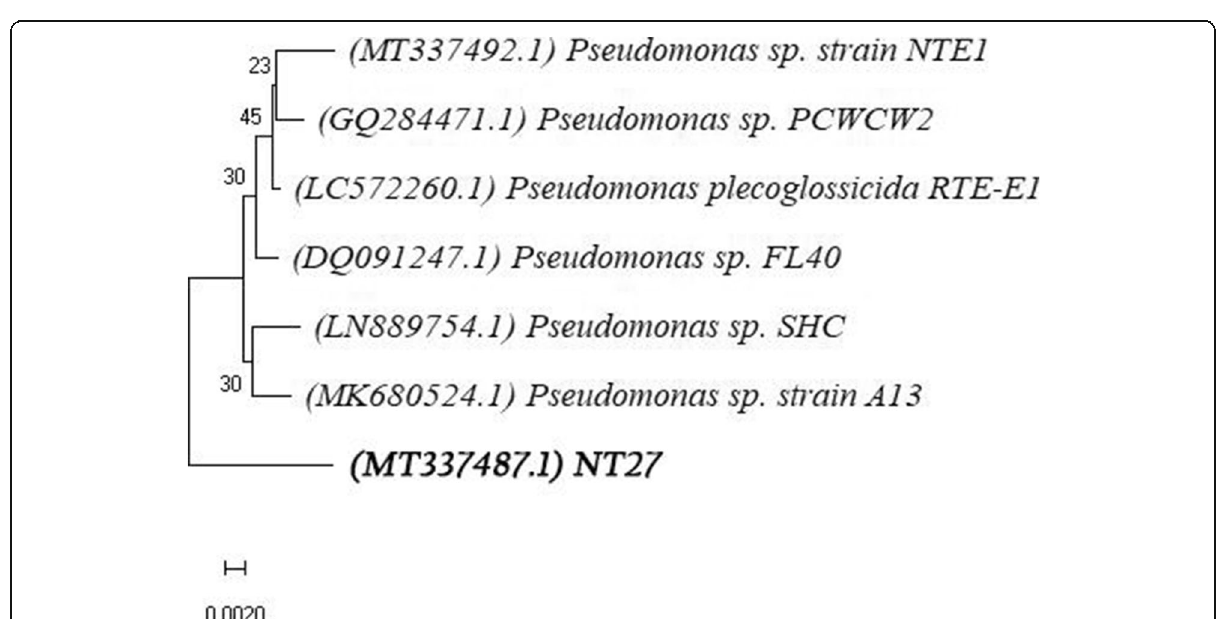
Fig. 3 Phylogenetic analysis of the isolate NT27 based on the sequencing of the 16S ribosomal RNA gene. The scale bar indicates 0.0020 substitutions per nucleotide